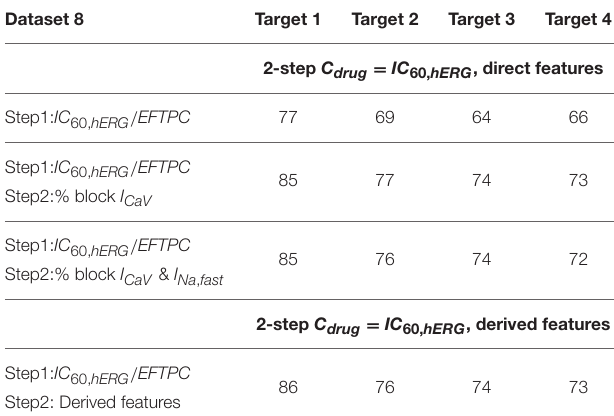
TABLE 6 | Accuracy scores of TdP classifiers on the direct features for Dataset 8 under four different TdP definitions.